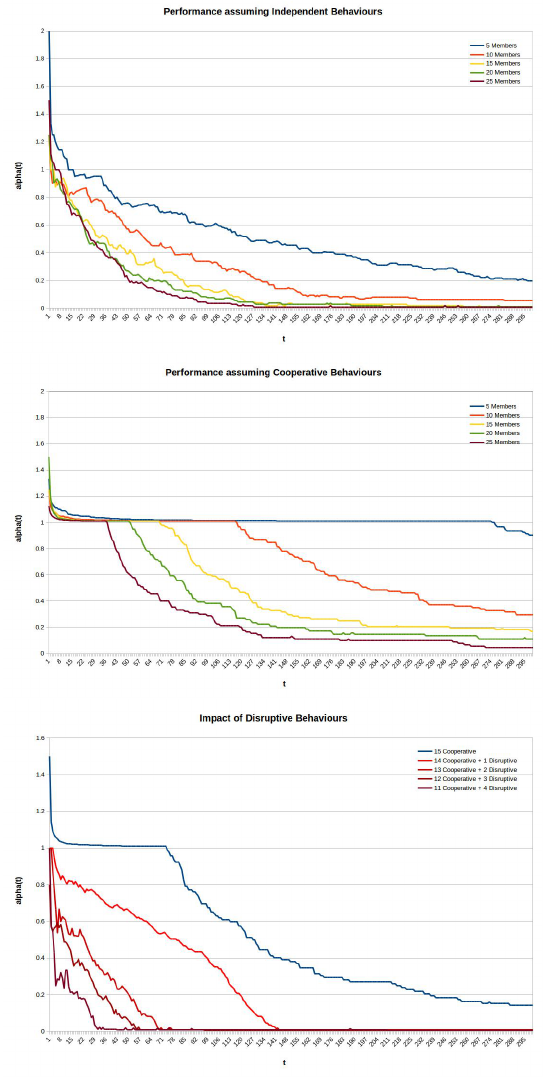
Figure 5. Simulation outcomes.